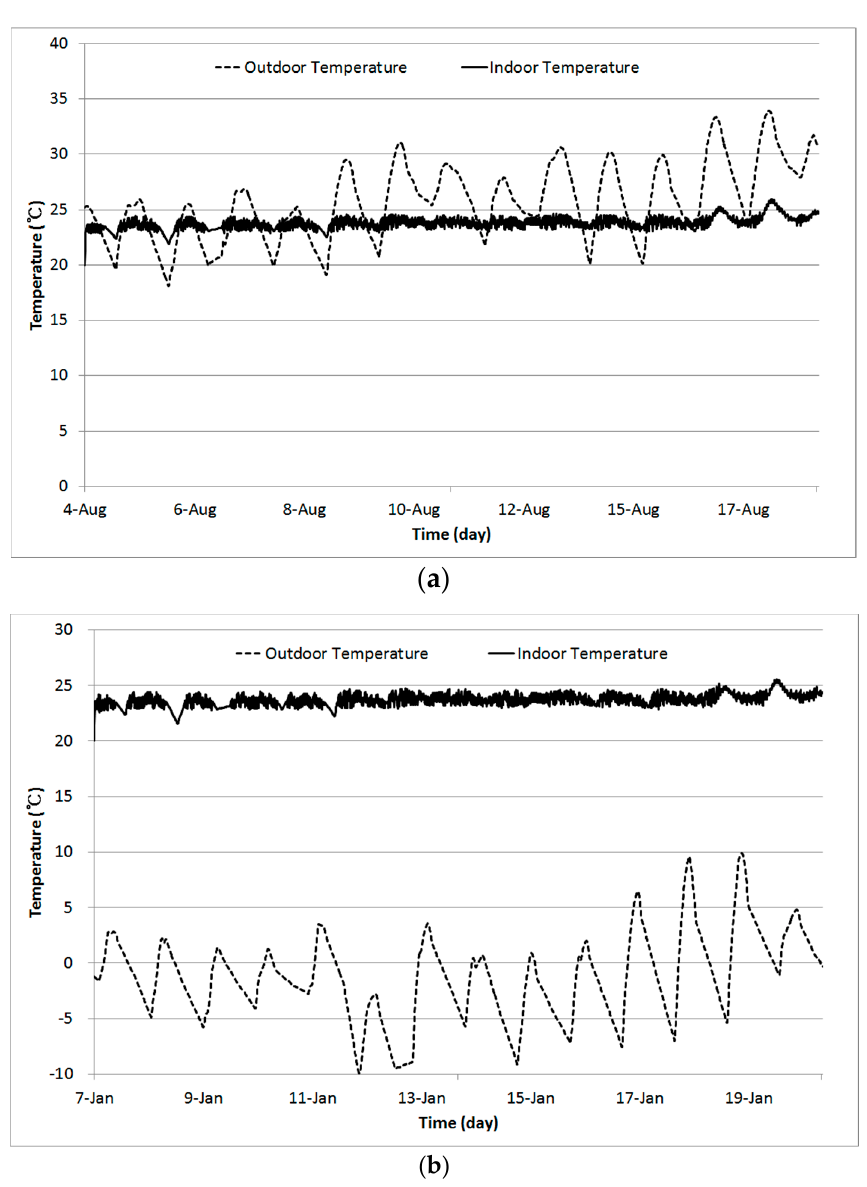
Figure 11. Indoor temperature in the existing CASE: ( a ) Summer; ( b ) Winter.